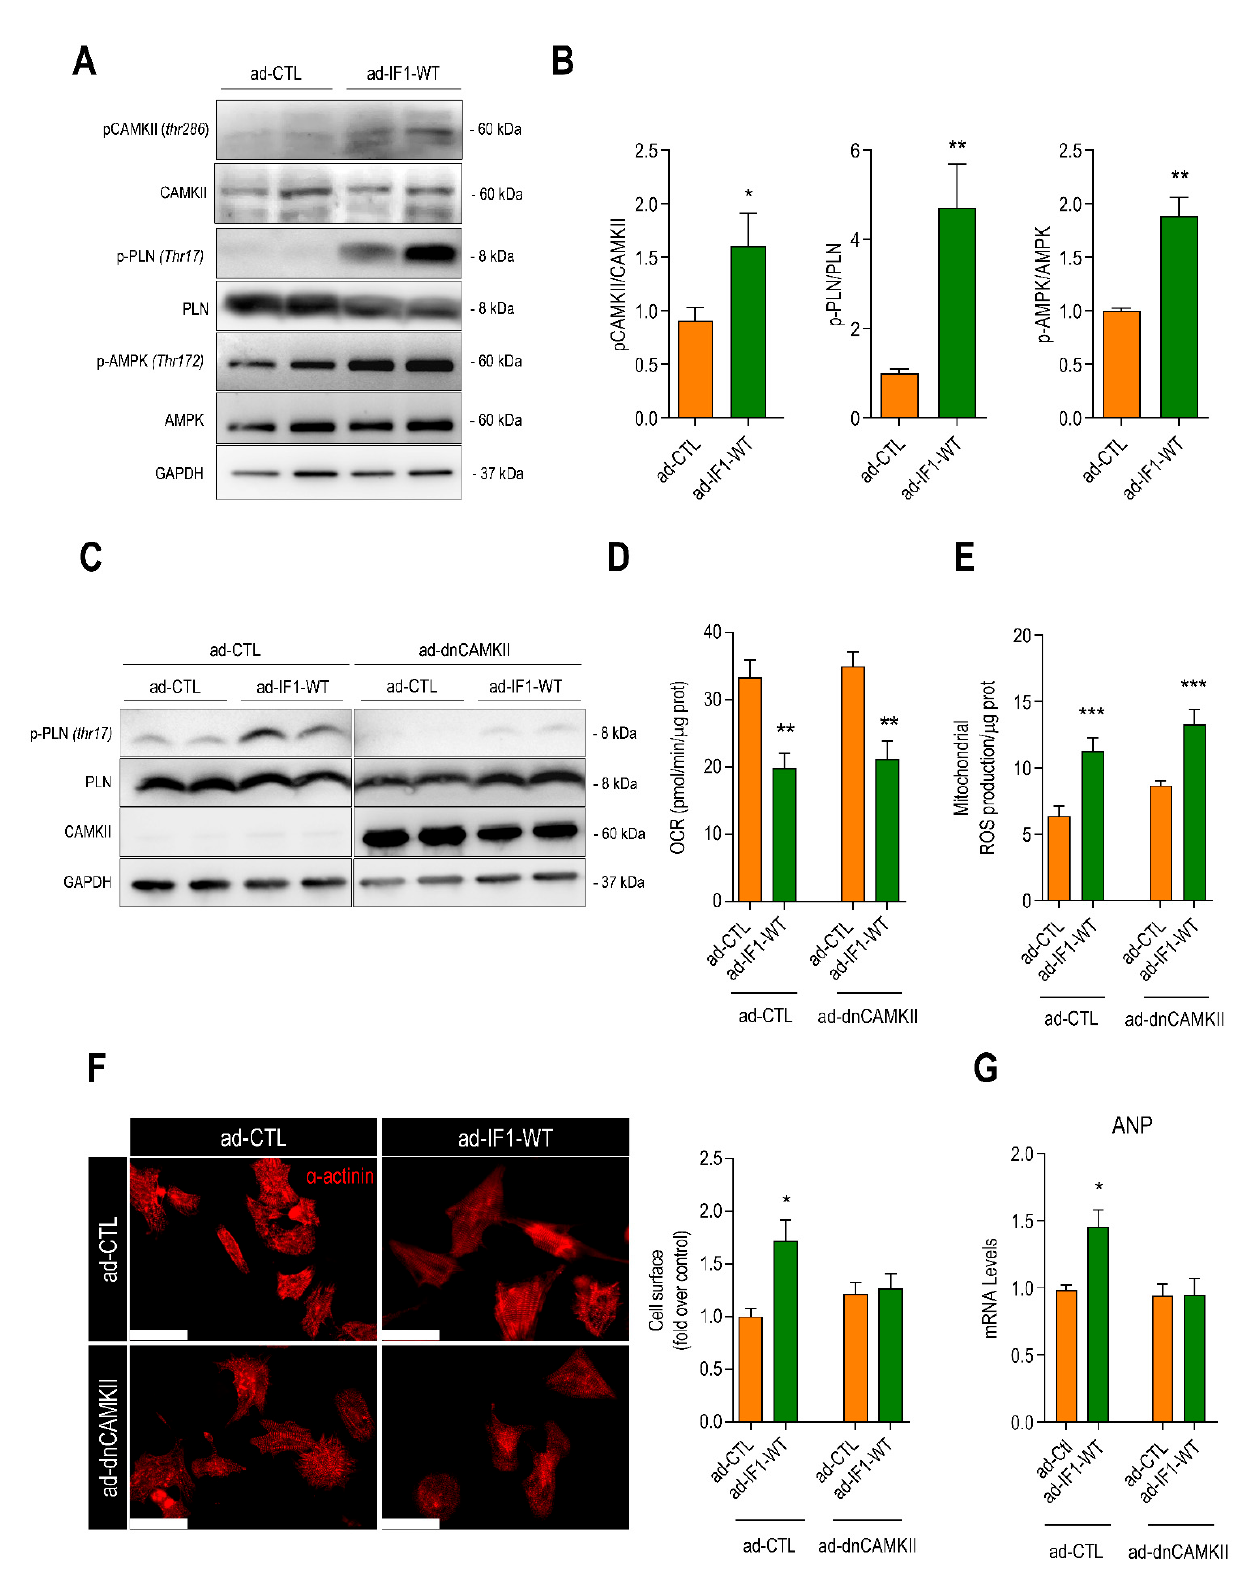
Figure 6. IF1-induced cardiomyocyte hypertrophy is dependent upon CaMKII δ activation. NRVMs were infected with adenovirus ad-IF1-WT and ad-CTL for 48 h. ( A ) Representative immunoblot depicting phosphorylation of CAMKII (threonine 286) and CaMKII-dependent phosphorylation of phospholamban (p-PLN, thr17) and adenosine monophosphate-activated protein kinase (p-AMPK, thr172), normalized for the total protein (left panel). ( B ) Bar graphs depicting differences in phosphorylation between experimental groups ( n = 7). ( C ) NRVMs were co-infected with adenovirus expressing